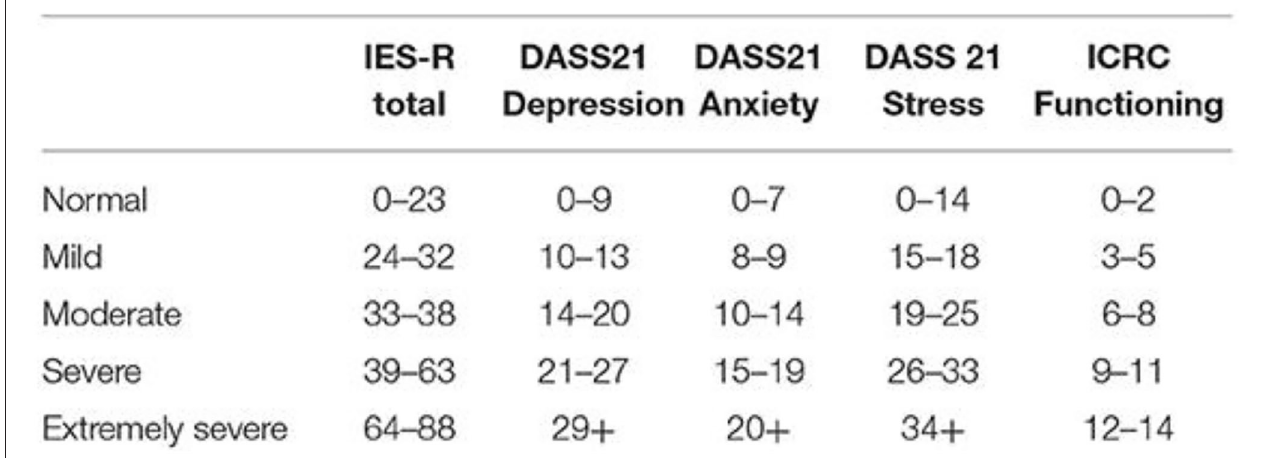
FIGURE 2 | Categorization of IES-R, DASS 21, and ICRC functioning scores used in this